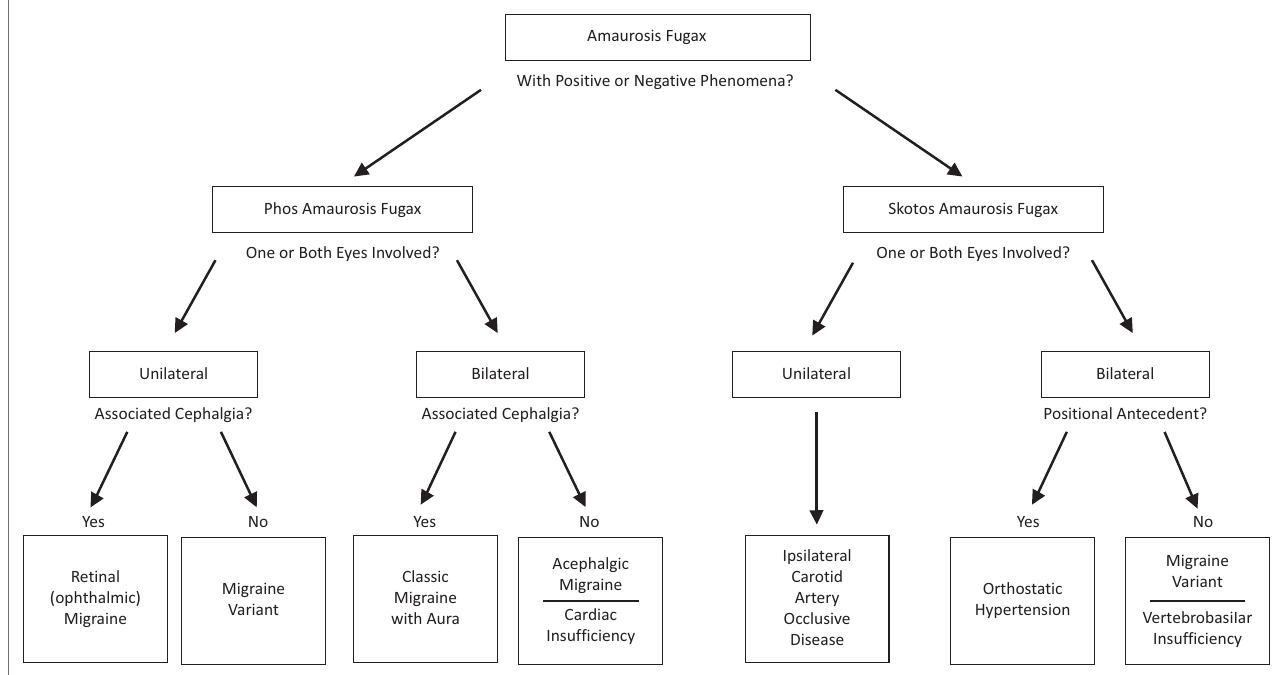
FIGURE 1: Differential diagnosis of phos and skotos amaurosis